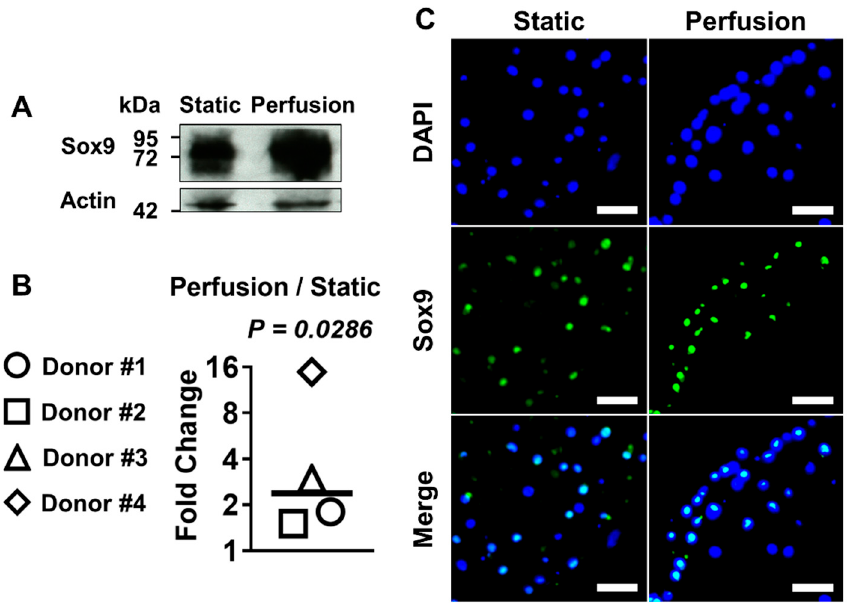
Figure 5. Perfusion increases Sox9 production by HACs. ( A ): Western blot (WB) analysis of Sox9 synthesis at the end of the in vitro culture period. Actin bands are shown as a control for equivalent loading of the extracts. ( B ): Quantification of Sox9 through the densitometric analysis of WB data. Sox9 was normalized to actin and the value of perfusion culture was then divided by the value obtained for the static culture of the same donor. Symbols in the dot plots represent a single donor data point and the bars represent the median. The level of significance of the statistical analysis ( p -value) is indicated. ( C ): Immunofluorescence staining of HACs embedded in hydrogels. Cells were stained for Sox9 with the Alexa Fluor 488-conjugated secondary antibody (green). Nuclei were stained with Hoechst dye (blue) (scale bars = 50 µm) ( n = 4).